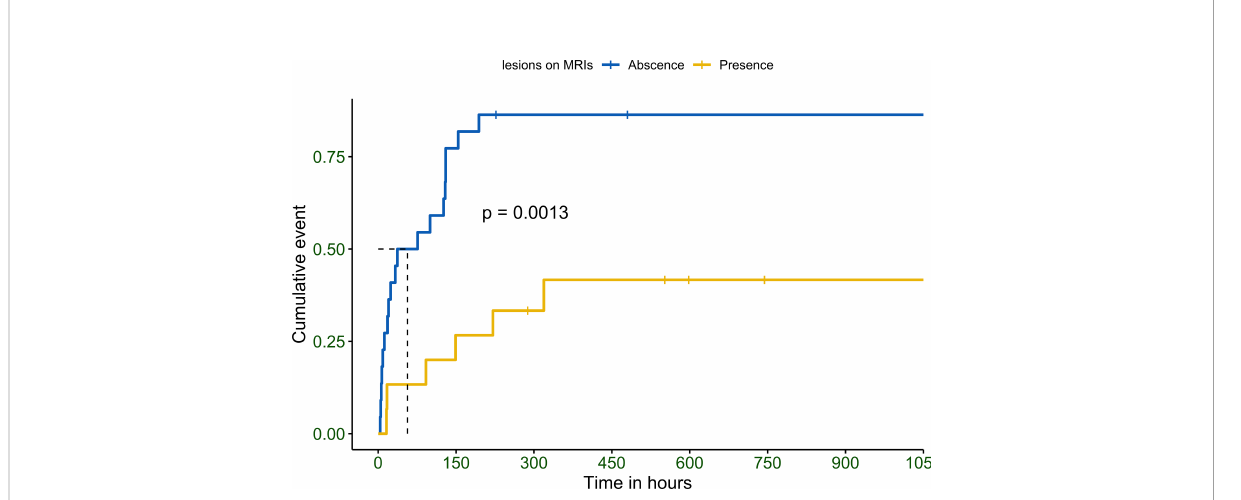
FIGURE 2 Observed Kaplan – Meier (KM) curve of probability for improvements in consciousness in patients with hypoglycemic encephalopathy depending on the detection of abnormal brain lesions in magnetic resonance imaging. P values calculated with the use of log-rank